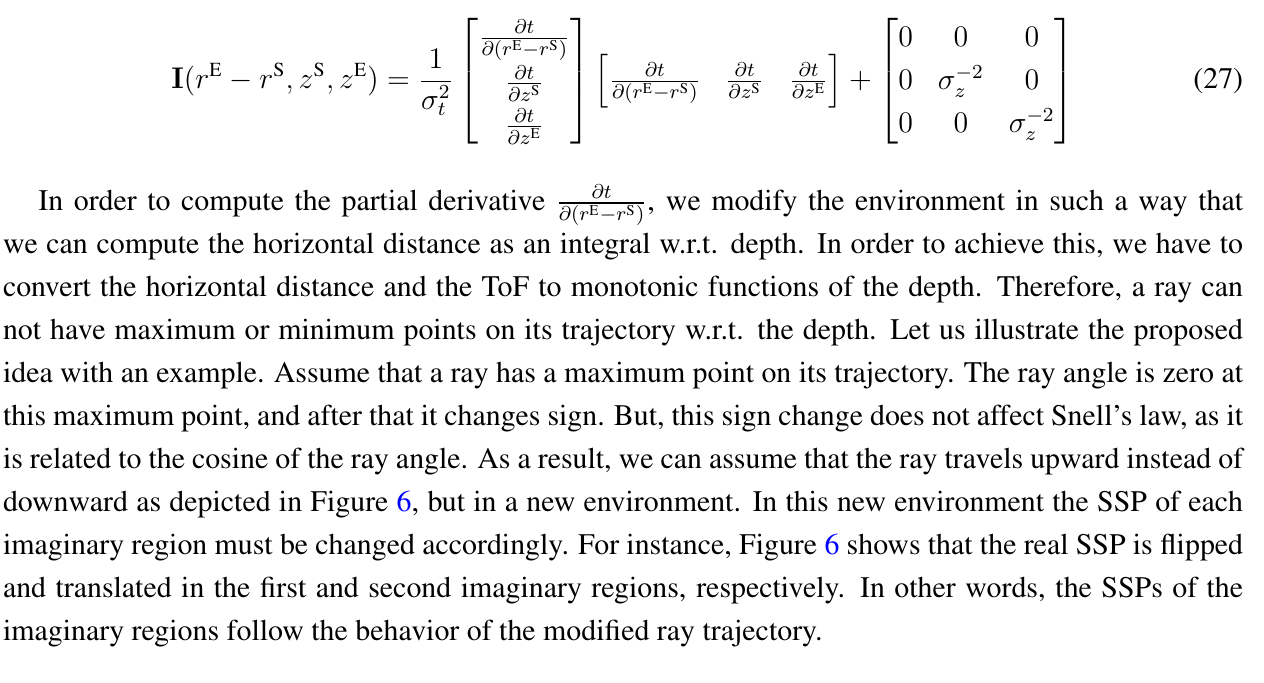
Figure 6. Changing the real ray trajectory into a trajectory which is a monotonic function of the